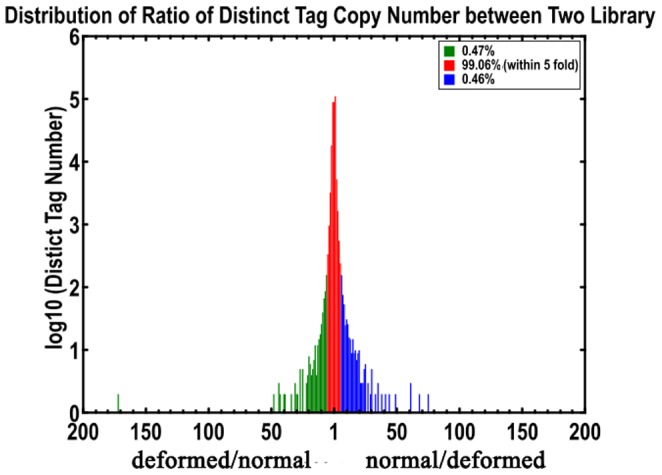
Distribution of ratios of distinct tag copy number between libraries of deformed and normal beak RNA.Red region represents the differentially expressed tags with differential expression less than 5-fold. Blue and green region represent the up- and down-regulated tags of more than 5-fold, respectively.